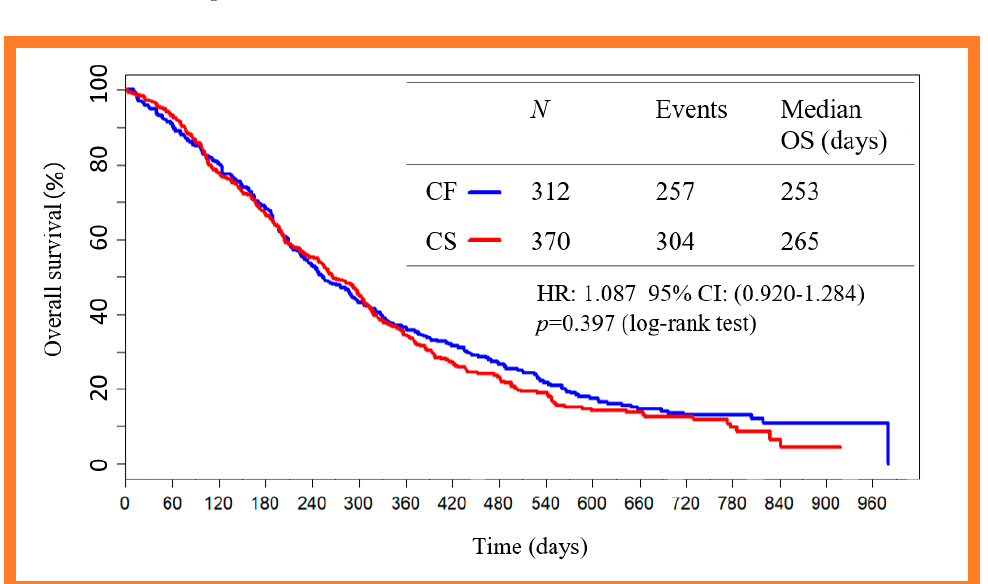
Figure 2. Kaplan–Meier plot of overall survival for the enrichable and non-enrichable population. (A) Enrichable population. (B) Non-enrichable population. CF, 5-fluorouracil/cisplatin; CS, S-1/Cisplatin; CI, confidence interval; HR, hazard ratio; OS, overall survival.